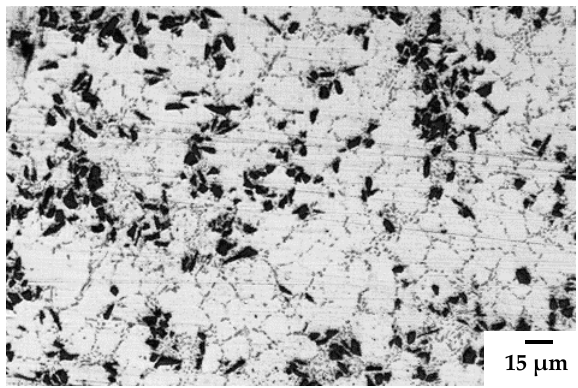
Figure 19. The microstructure of rheo-die-cast A356 / SiC ( 15%SiC - 15µm ) in T6 condition . Metals 2020 , 10 , 251